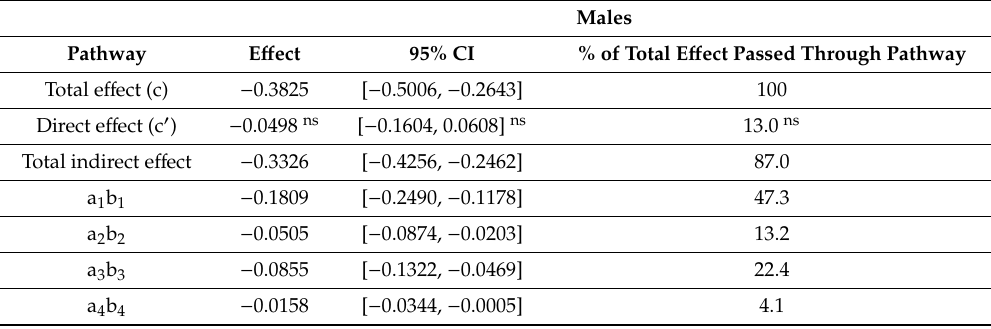
Figure 1. Quadruple mediation with individual effect per path. All paths are significant p < 0.05, except c’. Table 4. Direct and indirect e ff ects for mediating pathways for males of the relationship between stress in 2012 and work ability in 2017 in a parallel design ( n = 575).